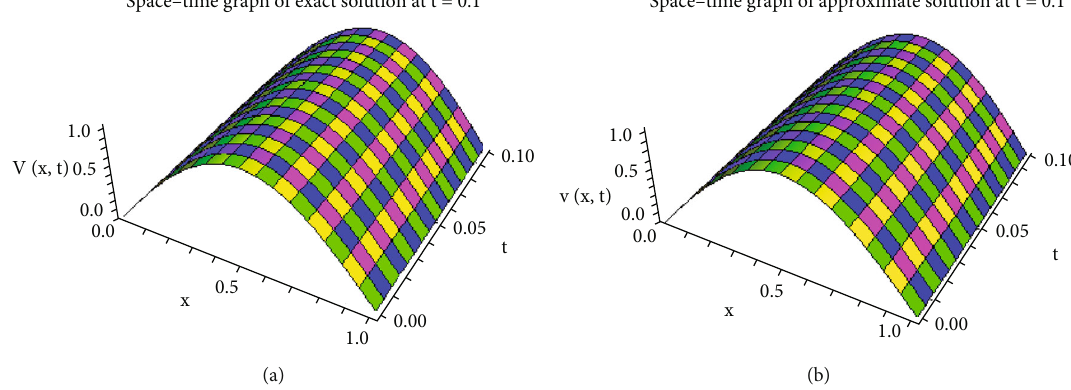
Figure 2: The approximate and exact solutions for Example 5 when h = 1/60, t = 0 : 1, Δ t = 0 : 01 .